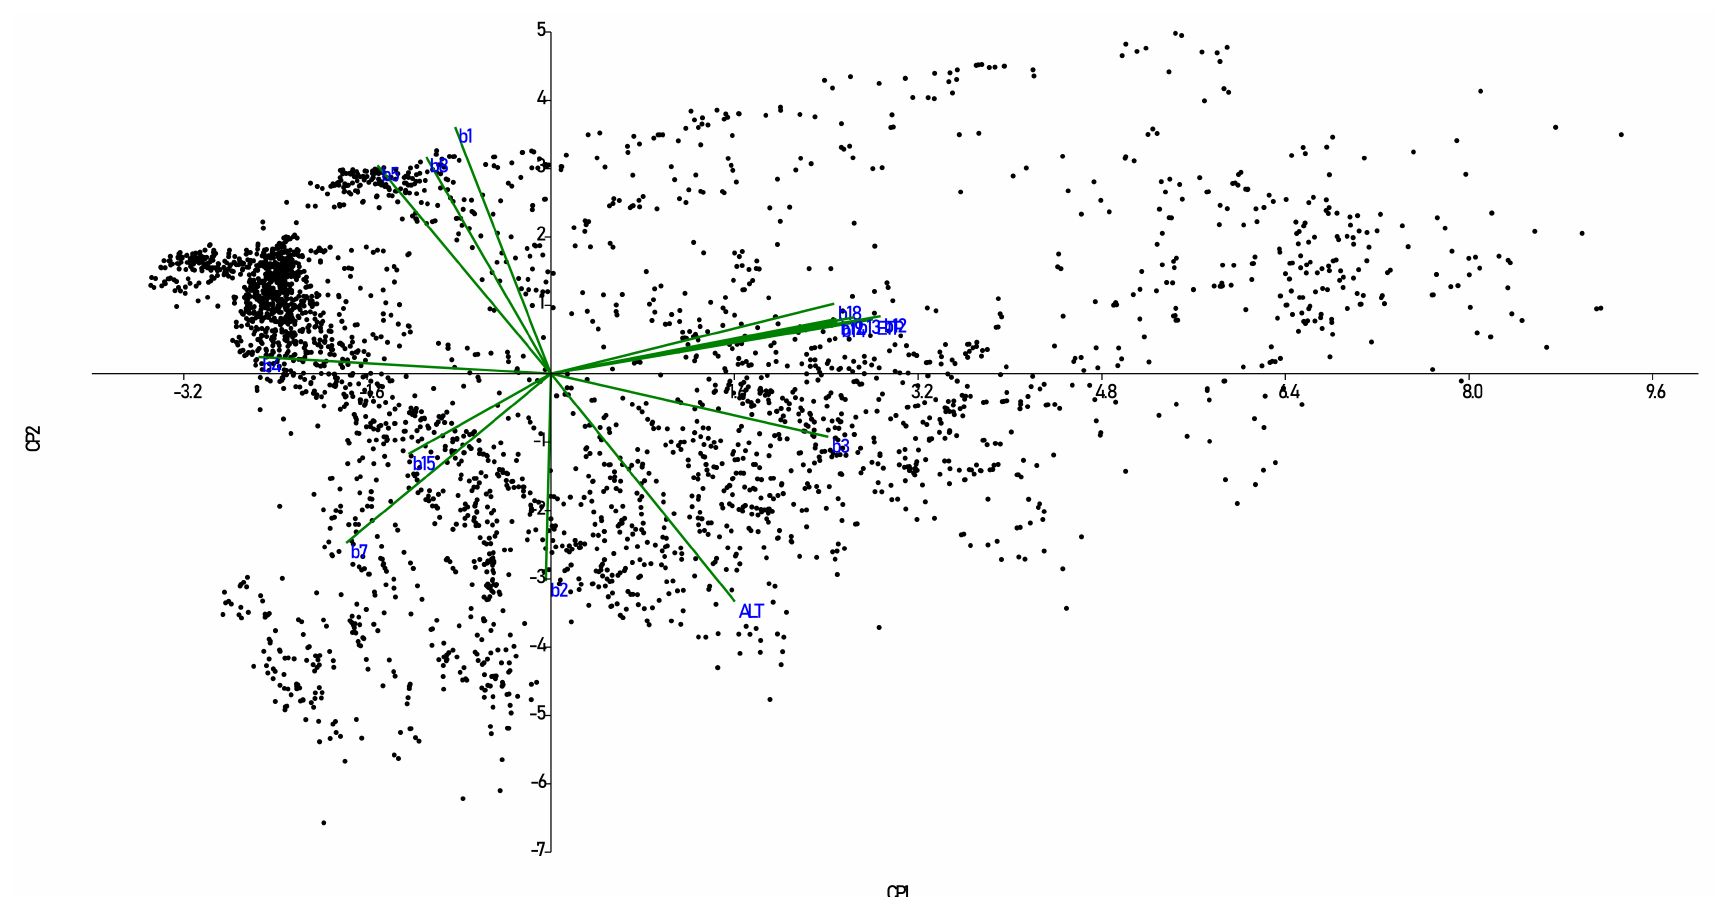
Figure 3. Biplot based on 4228 accessions of wild tomato and related species and 10 climatic variables. BIO13: precipitation of wettest month, BIO12: annual precipitation, ETPA: annual evapotranspiration, BIO1: annual mean temperature, BIO2: mean diurnal range, ALT: altitude, BIO8: mean temperature of wettest quarter, BIO5: maximum temperature of the warmest month, BIO15: coefficient of variation of seasonal precipitation, and BIO3: isothermality. PC1 and PC2 explained 47.8 and 27.2% of the total variation,